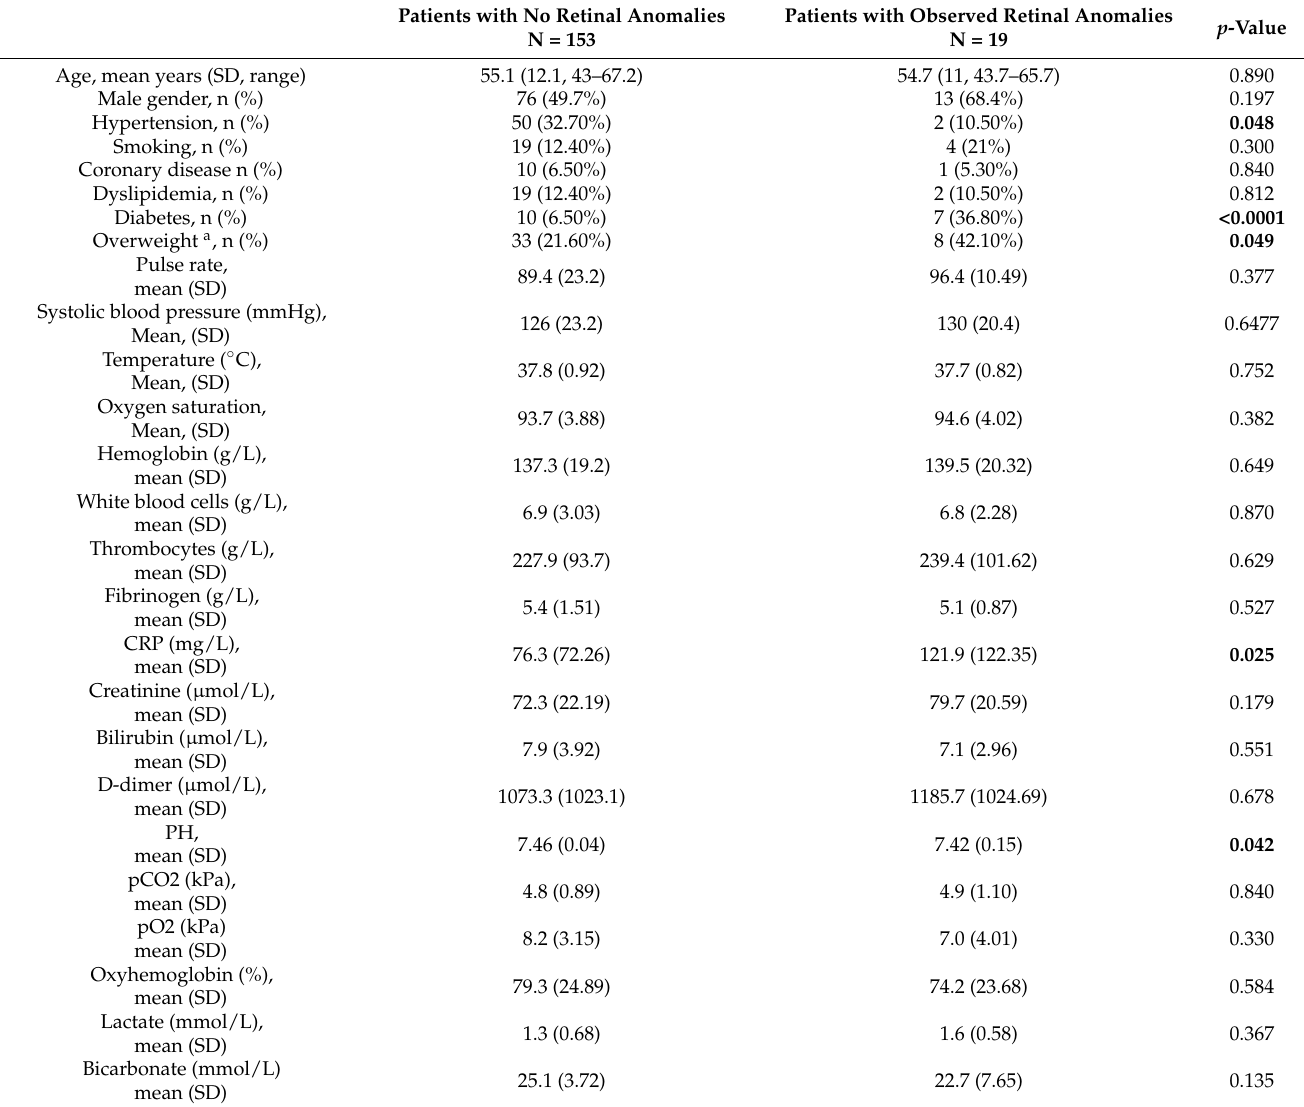
Table 1. Demographics, clinical features, and laboratory parameters of the 153 patients without retinal findings and of the 19 patients with observed retinal findings. Patients with No Retinal Anomalies Patients with Observed Retinal Anomalies p N = 153 N = 19